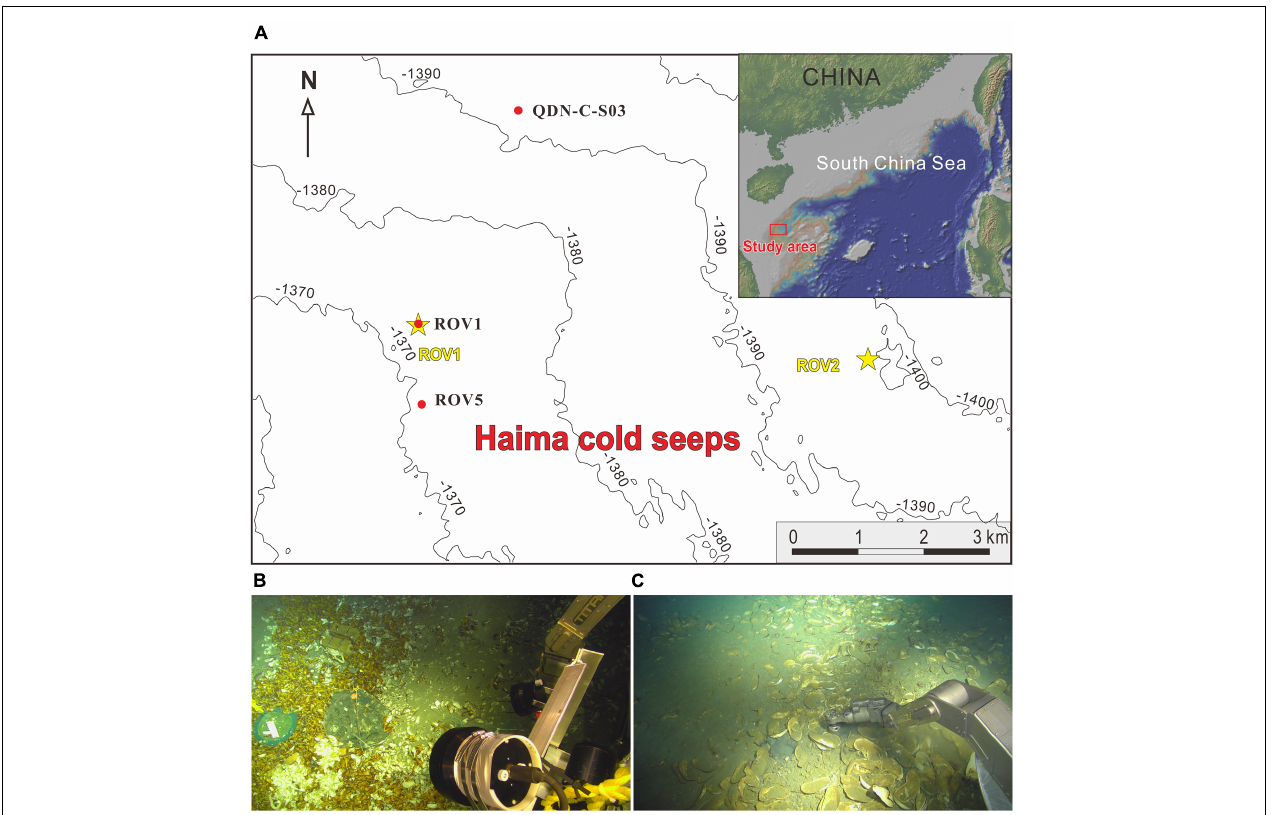
FIGURE 1 | (A) Locations of the three coring sites in the “Haima cold seeps” area. The yellow asterisks show the ROV1 and ROV2 seep areas. The red dots indicate the locations of coring sites. Cores ROV1 and ROV5 were taken from the active methane seep area and core QDN-C-S03 was collected from a non-seep area as a reference. Photos of seafloor where cores (B) ROV1 and (C) ROV5 were